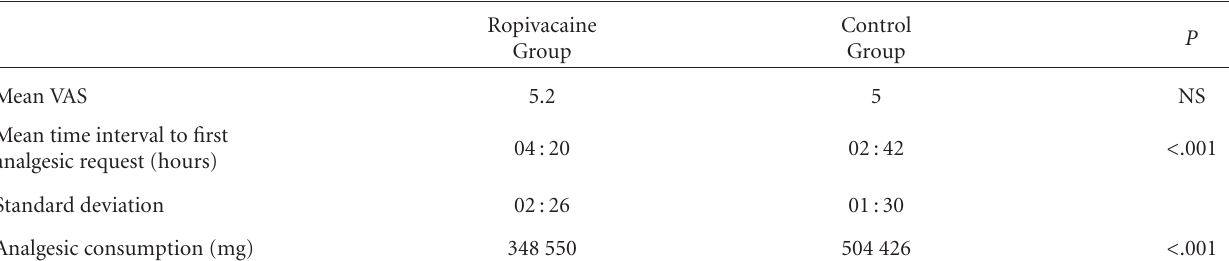
Table 3: Statistical analysis